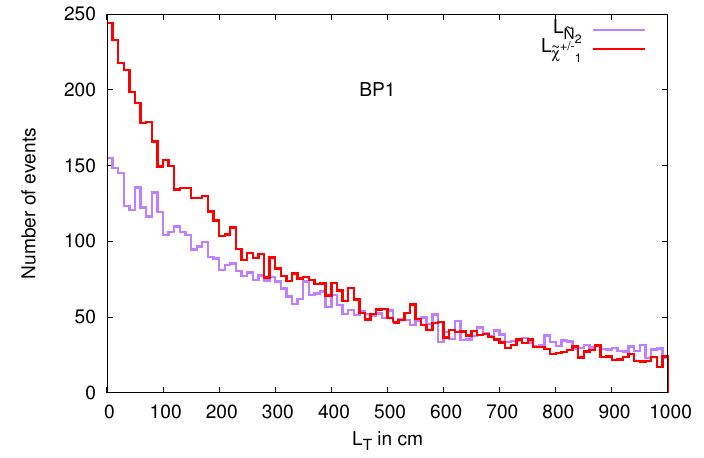
Figure 5. Displaced decay length of ~ N 2 and ~ (cid:31) (cid:6)